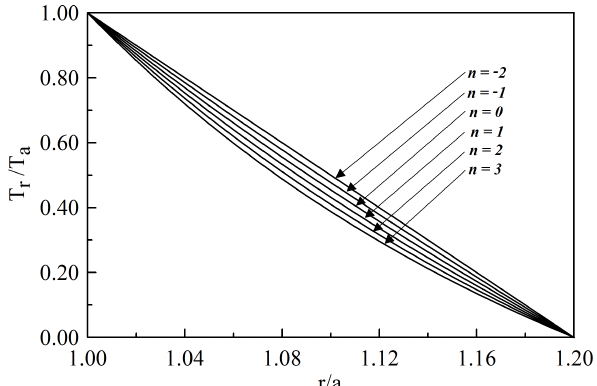
Figure 11: Radially distributed temperature